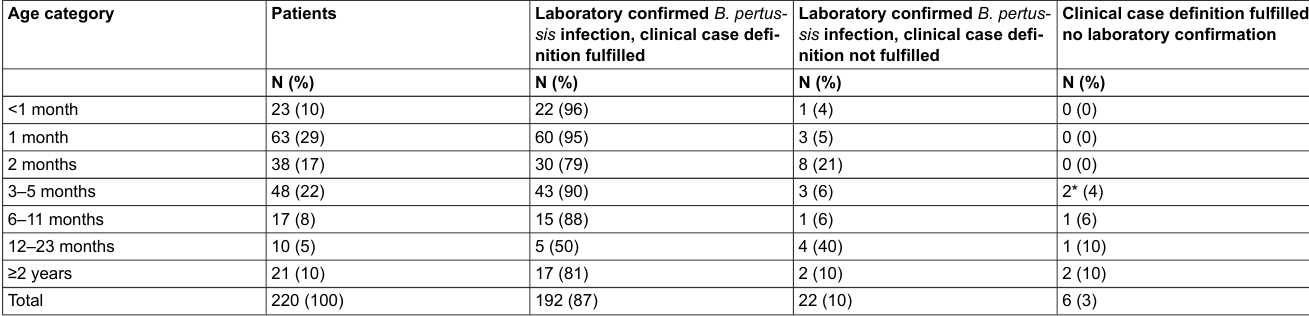
Table S1: Case definitions by age groups.